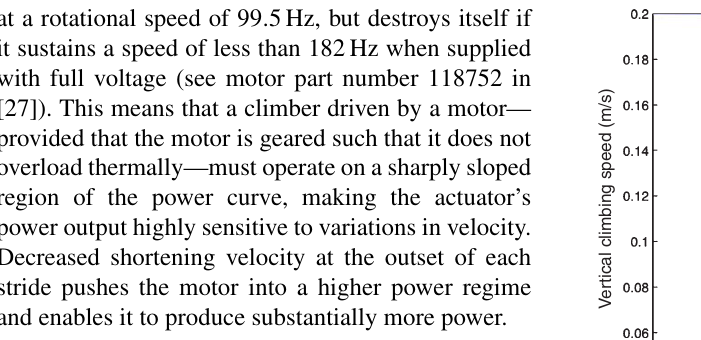
up until a sprawl angle of roughly 15 ◦ , changes in sprawl angle do not have a dramatic effect on verti- cal climbing speed. Though the animal does not seem to benefit energetically from a sprawl angle, it also does not seem to pay a speed penalty if it employs (a biologically accurate) 10 ◦ to 15 ◦